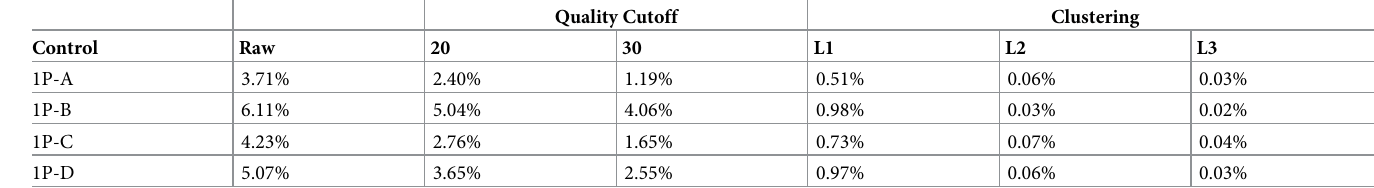
Table 2. Percent of erroneous barcodes in Illumina sequencing reads of single-plasmid controls: original (raw), quality thresholds for any base with each of two thresholds, and clustering with different Levenshtein distances